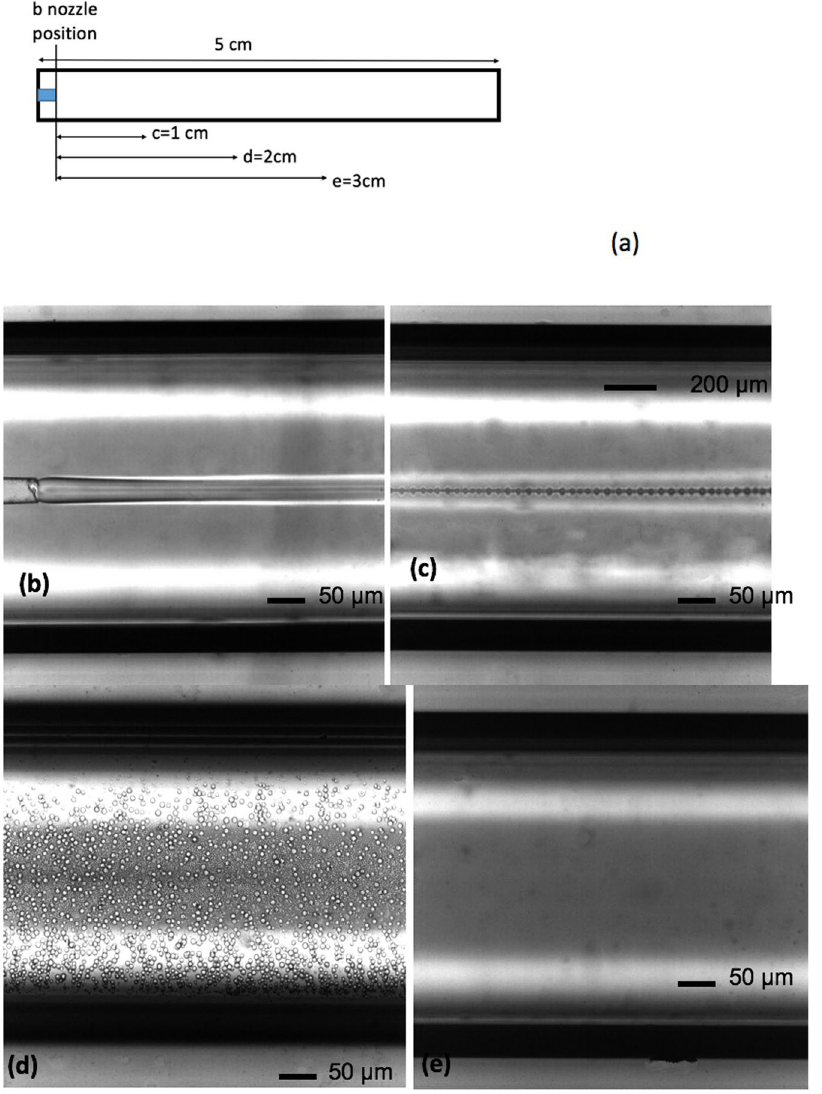
Figure 3. The evolution processes of different precursor fluids. ( a ) Scheme of the device with locations of the position for the images (b–e); ( b – e ) Flow-focusing of partially water-miscible precursor ( V DCM / V DMSO = 1/10) and water, Qcon = 10000 µ L/hr, Qdis = 100 µ L/hr. Photos were taken at positions close to nozzle ( b ), 10 mm after nozzle ( c ), 20 mm after nozzle ( d ), and 30 mm after nozzle ( e ), along the flow direction, successively. After 30 mm, the size of the droplets is submicronic since they are not observable using an optical